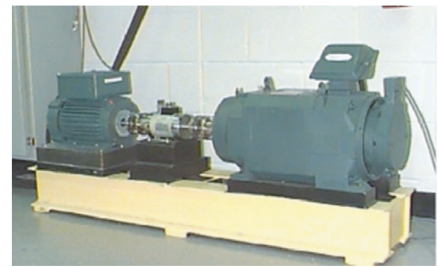
Figure 4: Bearing testbed used for